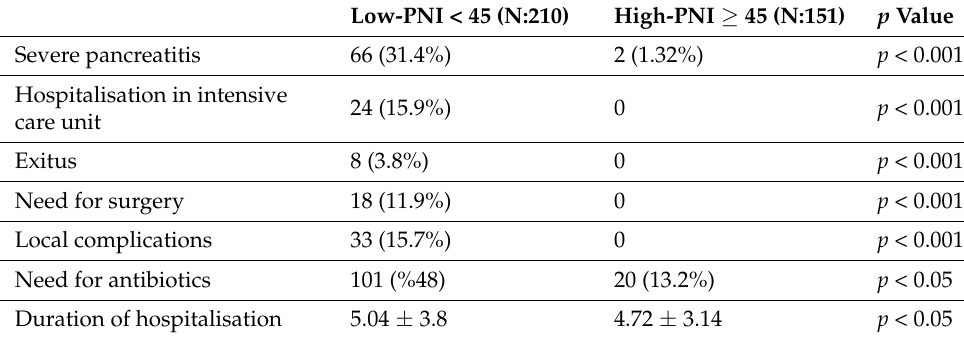
Table 4. Categorisation according to Prognostic Nutritional Index (PNI).